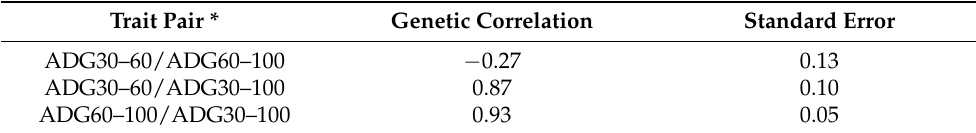
Table 2. Genetic correlations among three ADG traits in crossbred